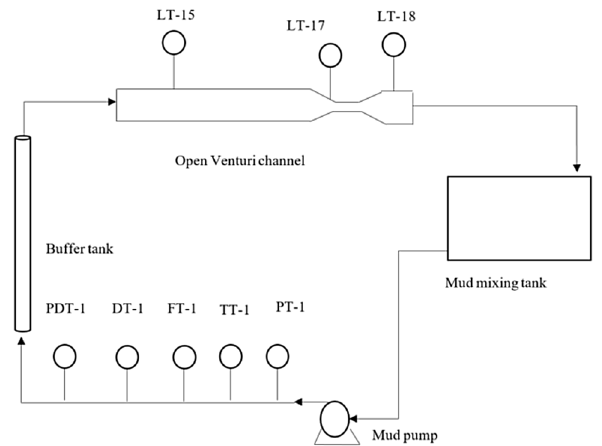
Fig. 2 Flow loop of the experimental setup: LT level transmitter, PT pressure transmitter, TT temperature transmitter, DT density transmit- ter, and PDT differential pressure transmitter. The level transmitters are possible to move along the central axis of the channel